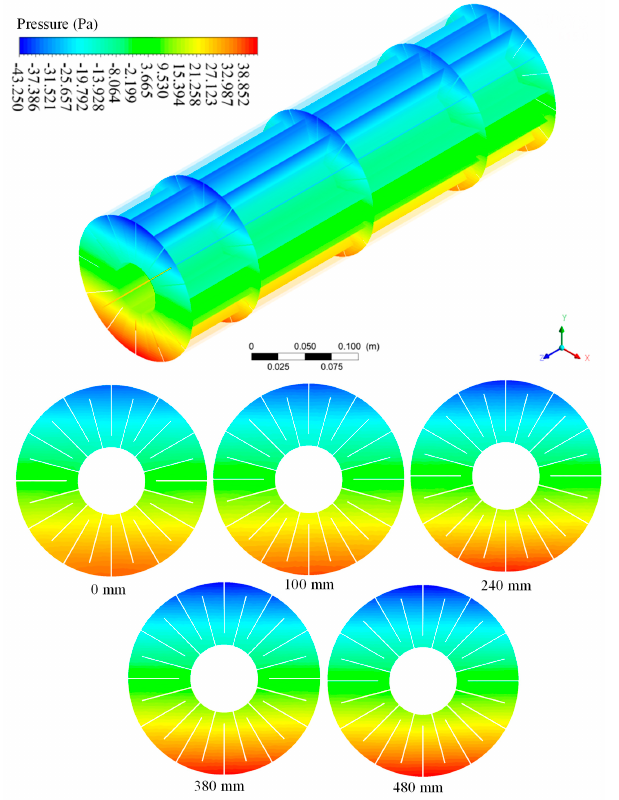
Figure 19. Pressure distribution in the PCM domain for 30% (t = 7852 s) of its volume in liquid state.